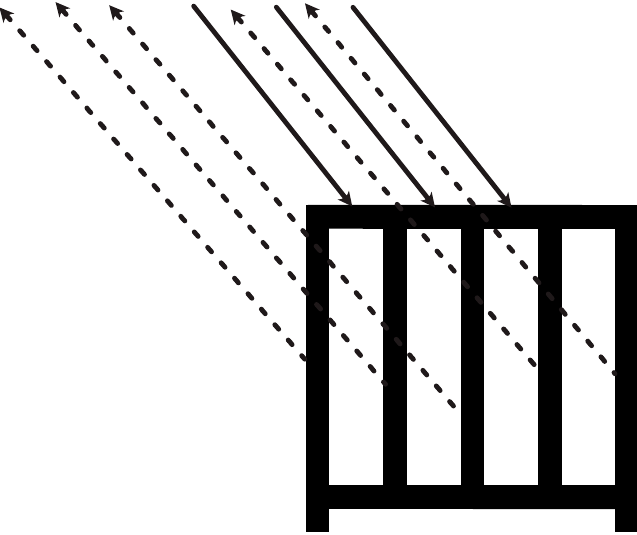
Figure 12. Metallic fence working as cross-polarizing antenna with incoming signal in horizontal polarization received by the horizontal bars and reflected/transmitted in vertical polarization by the vertical bars.